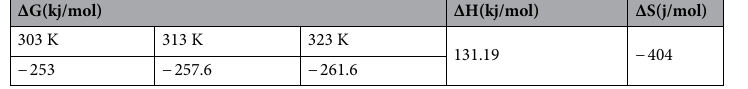
Table 11. Thermodynamics parameters for MB adsorption on PVA/CMC/TUR film.